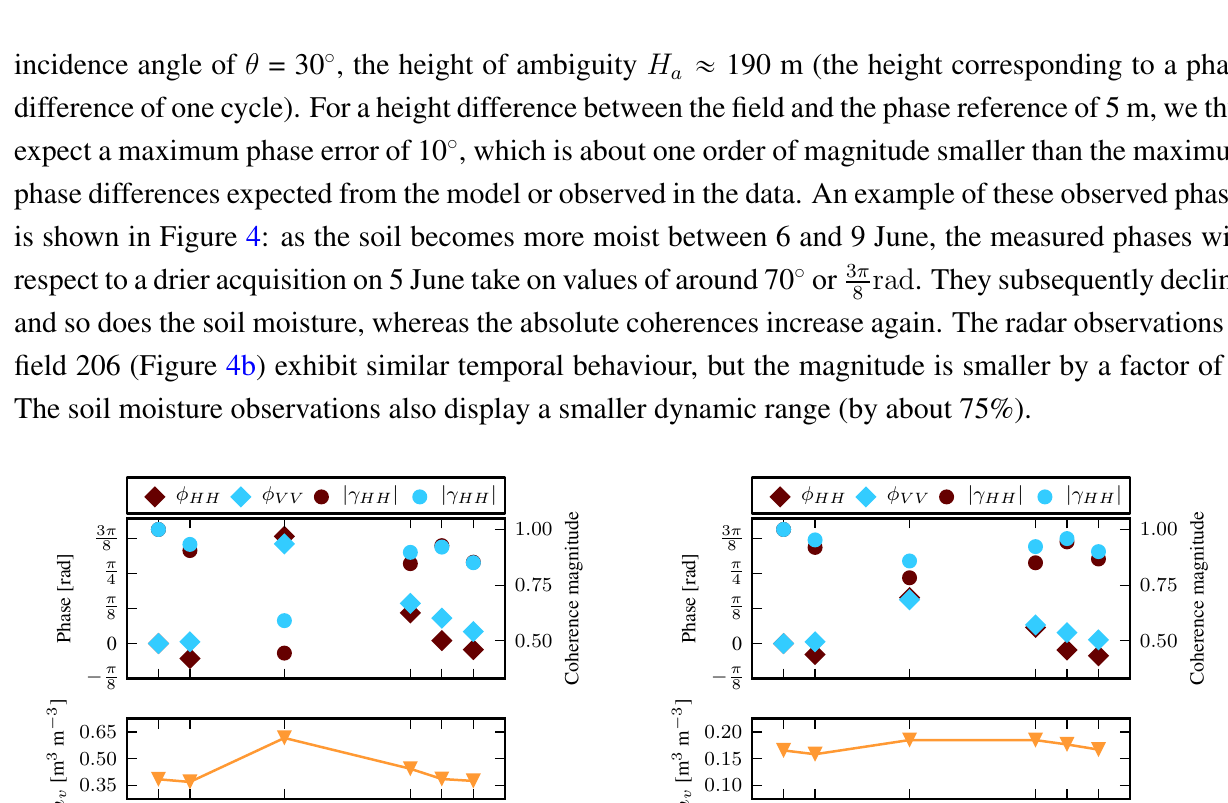
measured in the v